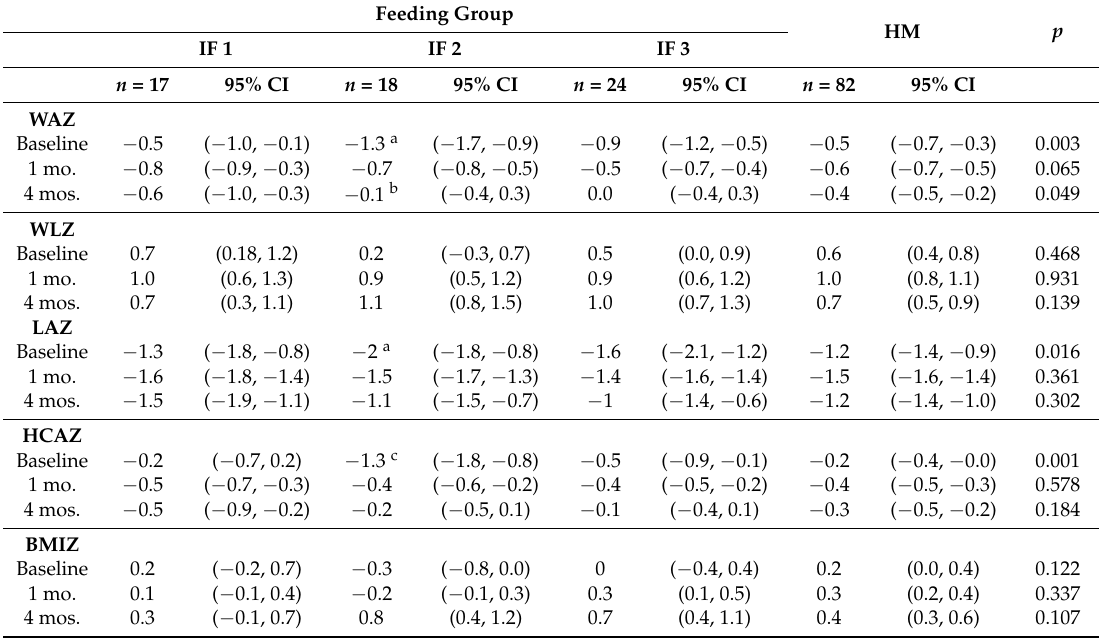
Table 6. Mean Z-score values (95% CI) at baseline, 1 month of age, and 4 months of age by feeding group. Feeding